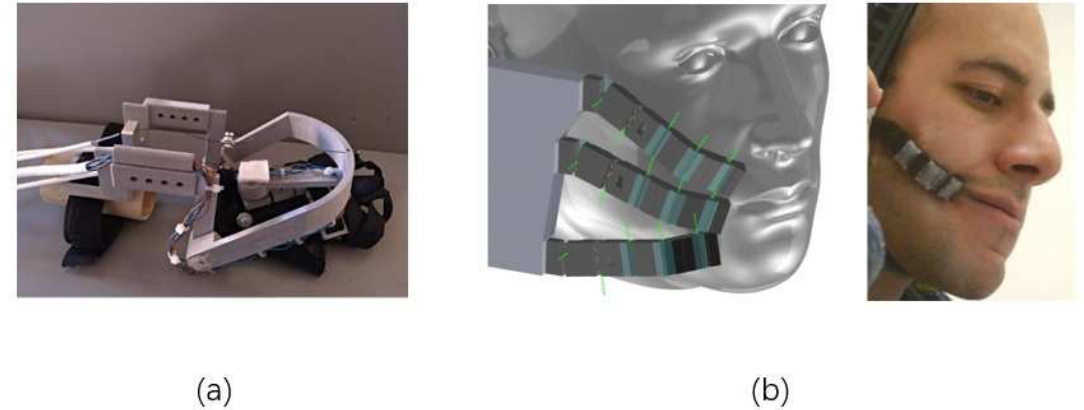
Figure 5. Soft rehabilitation and nursing-care robots based on other soft intelligent materials. ( a ) is reprinted from [81]. ( b ) is reprinted from [84].